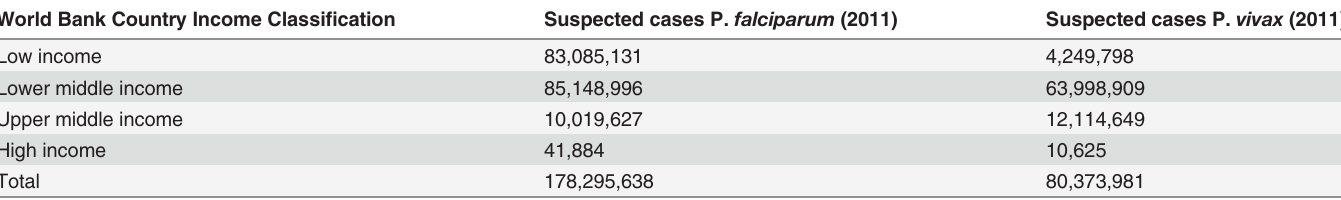
Table 3. Suspected cases (in 2011) by type of malaria and income classi fi